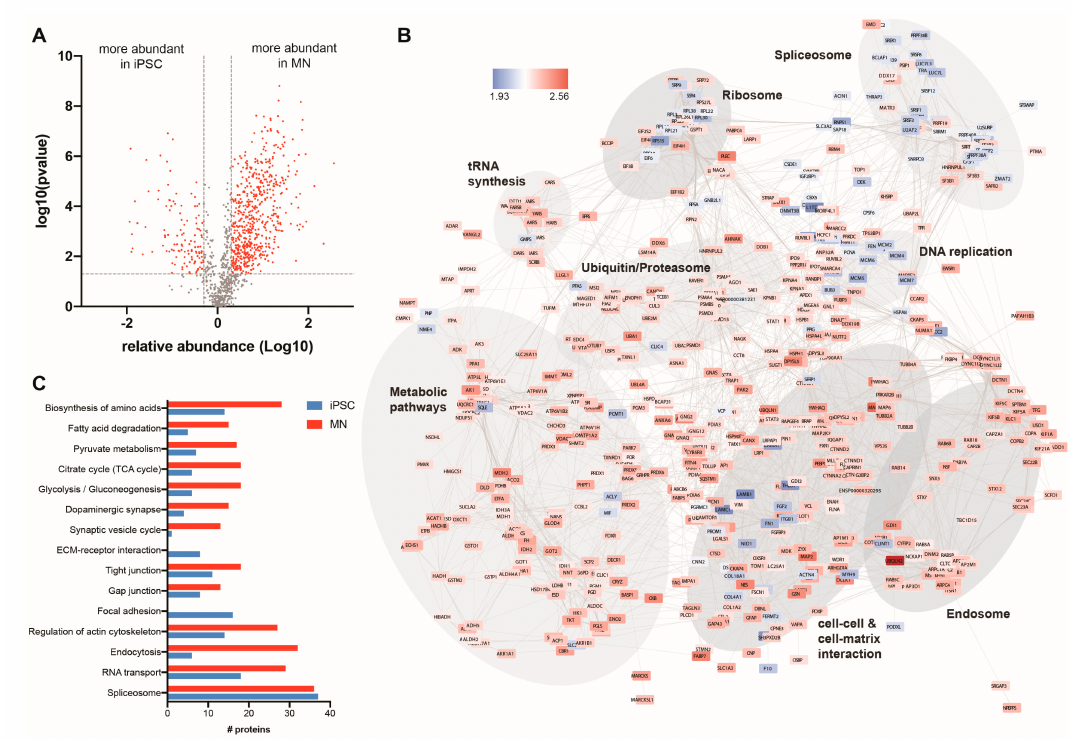
Figure 3. Ubiquitome changes following iPSC di ff erentiation to motor neurons. ( A ) Volcano plot (Log10 abundance vs. − log10 p -value) to determine significantly enriched proteins in the ubiquitome of iPSC and iPSC-derived motor neurons. Proteins with adjusted p < 0.01 and fold change > 2 are shown in red ( B ) Protein–protein interaction map of di ff erentially enriched proteins in the ubiquitome of iPSCs (blue) and motor neurons (red) as determined by STRING analysis (confidence score > 0.700). ( C ) Functional enrichment of di ff erentially expressed proteins within the ubiquitome of iPSCs and motor neurons, showing the number of individual proteins present in each KEGG pathway in each cell state (data from n =